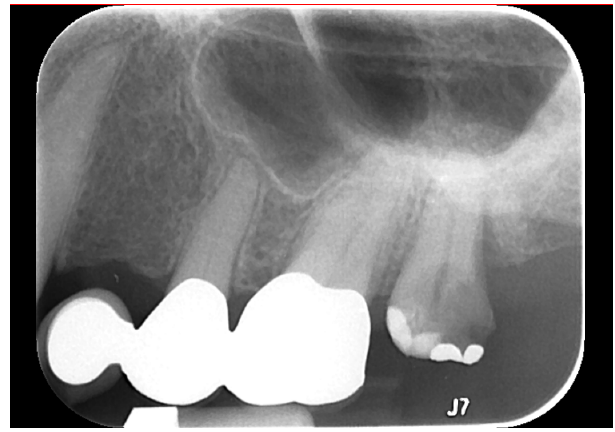
Figure 2. Periapical radiograph demonstrating a large carious le- sion at no. 15 with associated widening of periodontal ligament and periapical radiolucency consistent with implant